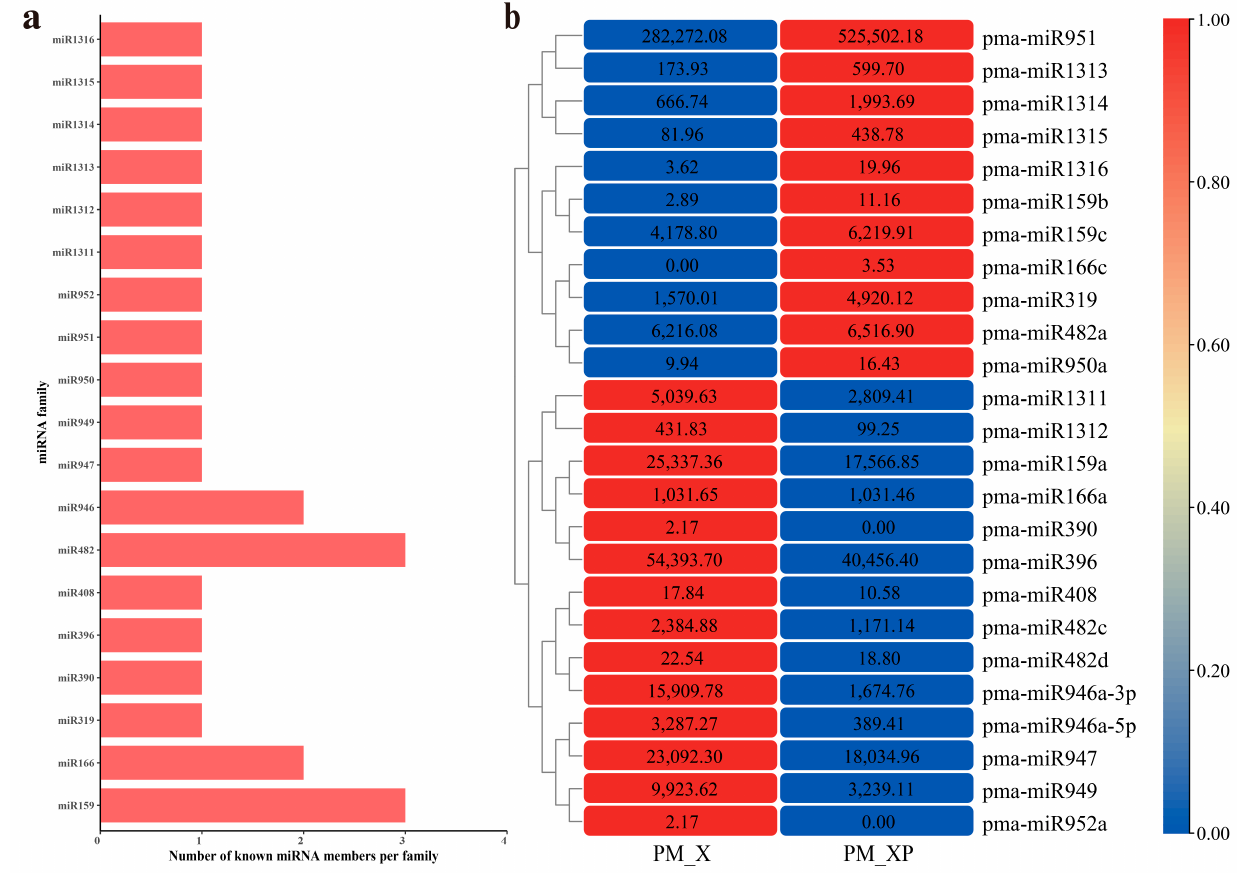
Figure 2. The conserved miRNAs in P. massoniana . ( a ) Member numbers of conserved miRNAs. ( b ) The expression of conserved miRNAs. MiRNA expression was log 10 (TPM + 1) processed and normalized, and the detailed expression of miRNAs is shown in black font in the figure.